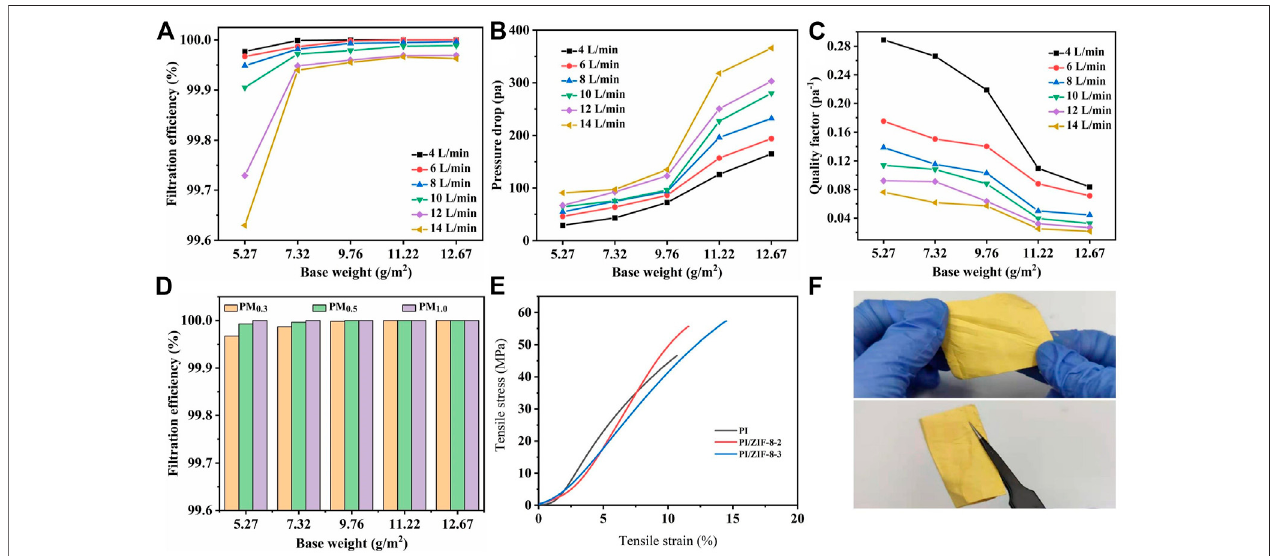
FIGURE4| The fi ltrationef fi ciency (A) ,pressuredrop (B) ,andqualityfactor (C) oftheZIF-8-3/PImembranesvariedwithbaseweightandair fl owrate. (D) Effectsof differentbaseweightsoftheZIF-8/PInano fi bermembranesonthe fi ltrationef fi ciencyofPM 0.3 ,PM 0.5 ,andPM 1.0 . (E) Stress – straincurves. (F) Rigidityand fl exibilityofthe ZIF-8/PI nano fi ber